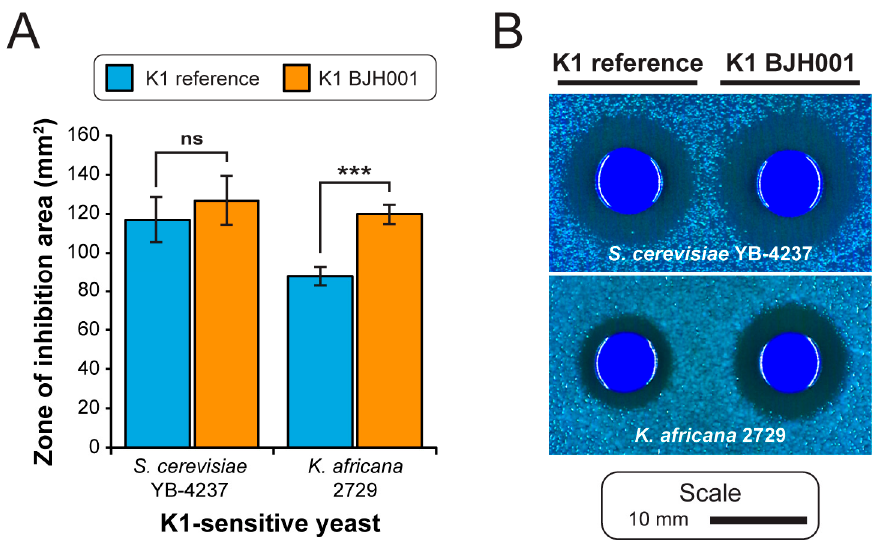
Figure 5. Mutations within the K1 gene increases the ability of the killer toxin to inhibit the growth of the yeast Kazachstania africana in vitro . ( A ) The change in the area of growth inhibition around K1-expressing S. cerevisiae challenged with di ff erent strains of K1-sensitive yeasts measured in mm 2 . Asterisks are indicative of a significant di ff erence in the mean zone of the inhibition area (T-test, two-tailed, *** p < 0.01, ns indicates no significant di ff erence). Error bars represent standard error of three independent repeats. ( B ) Representative images of the isogenic non-killer yeast strains expressing di ff erent K1 killer toxins (derived from the K1 reference sequence or K1 from S. cerevisiae BJH001), on agar seeded with yeasts known to be sensitive to K1 killer toxins.